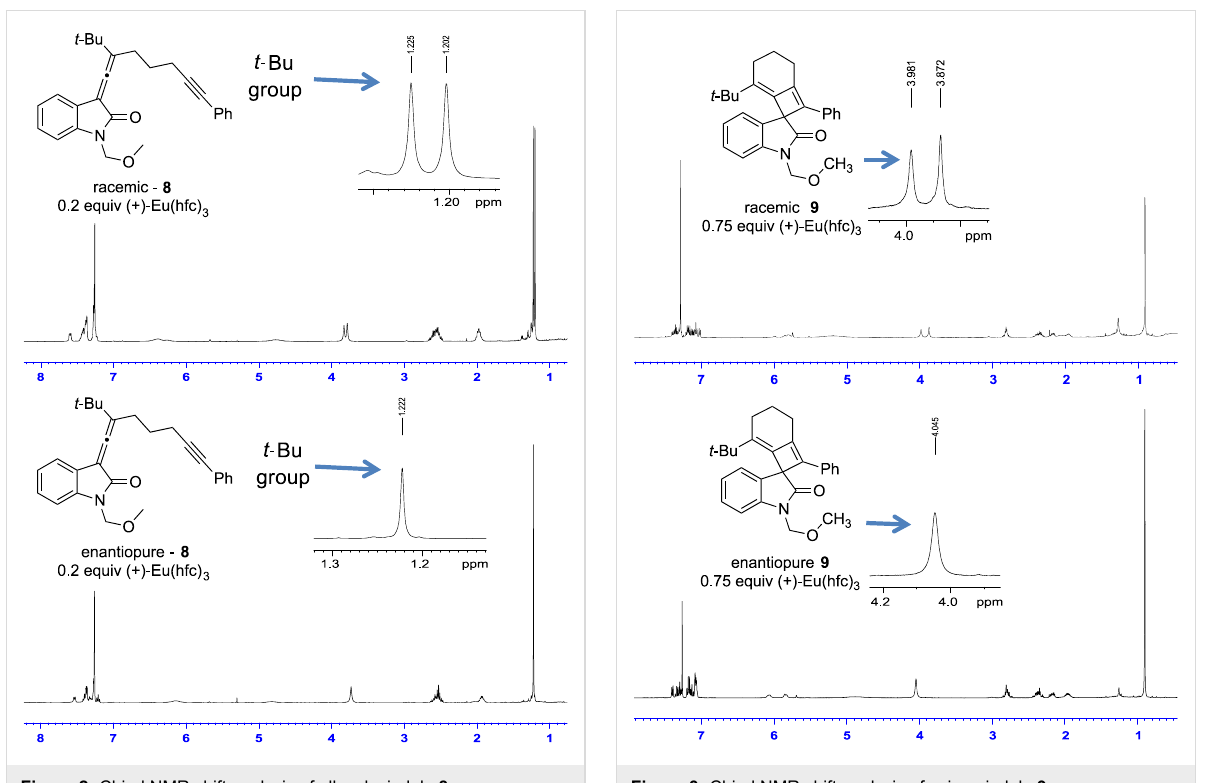
Figure 2: Chiral NMR shift analysis of allenyloxindole 8 .